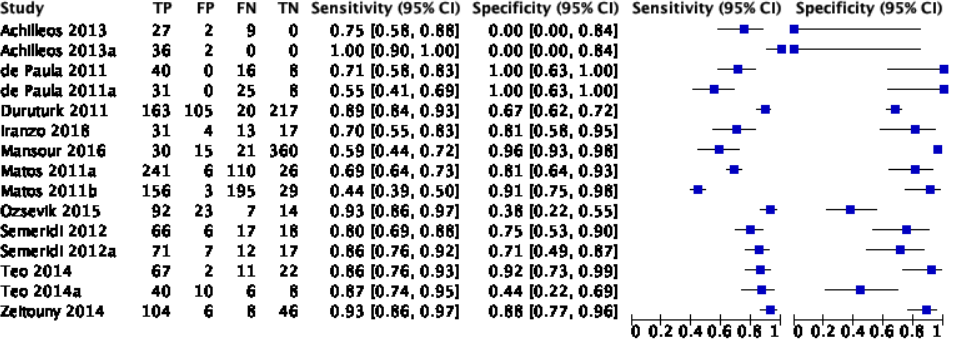
Figure A3. Fluorescence-based